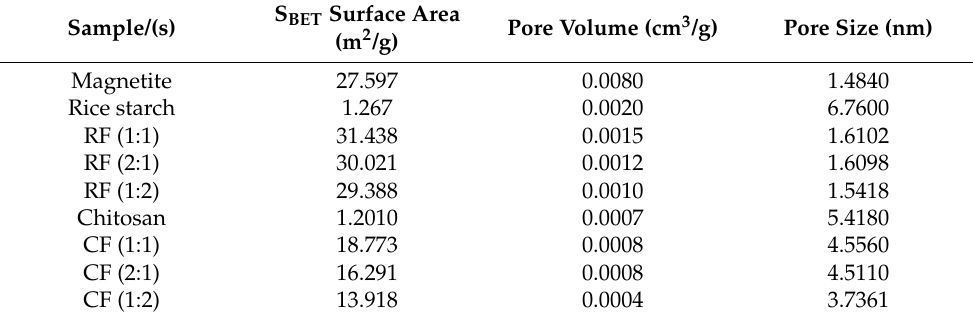
Table 7. Comparison of the BET surface area of the